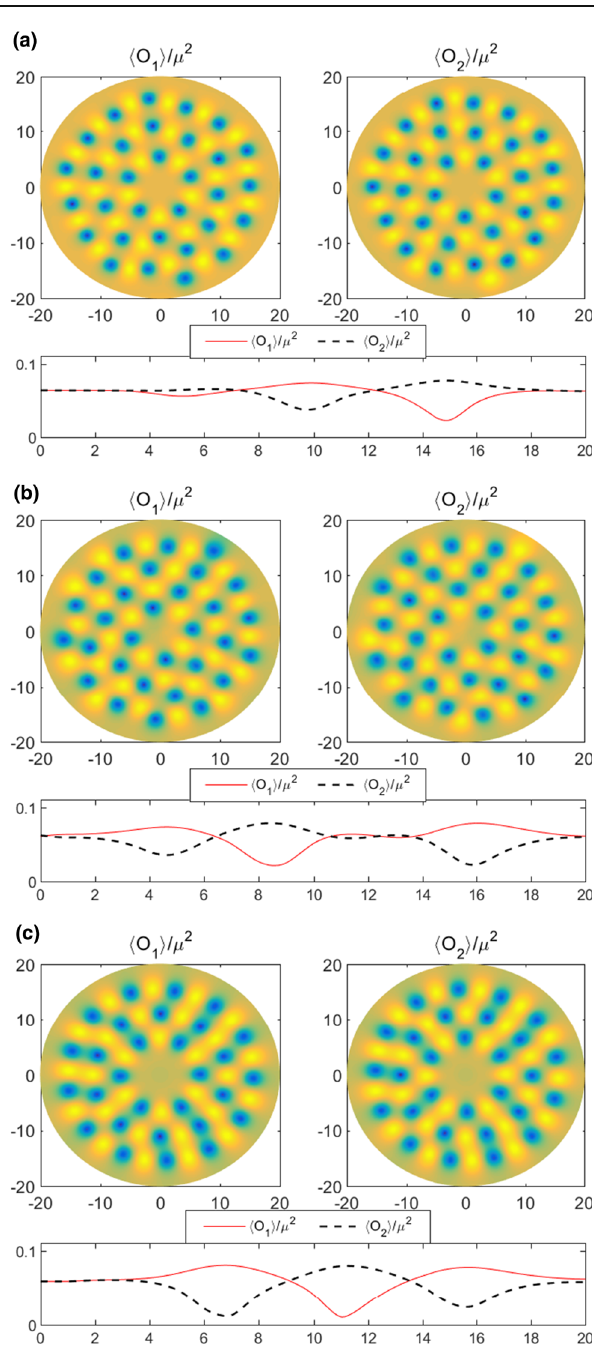
Fig. 3 Four typical vortex phases at T = 0 . 82 T 0 c and the correspond- ing radial profiles of (cid:3) O 1 , 2 (cid:4) in the θ = π/ 2 direction: a η = − 0 . 6 ,Ω